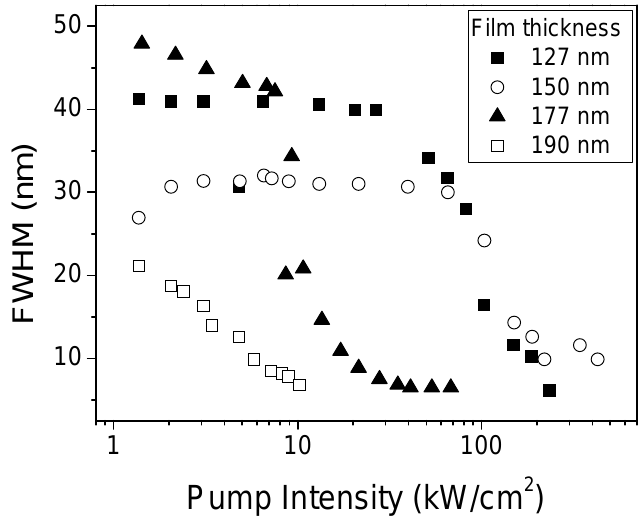
Figure 8. FWHM as a function of pump intensity for 15 wt% TPD-doped PS films of various thickness.